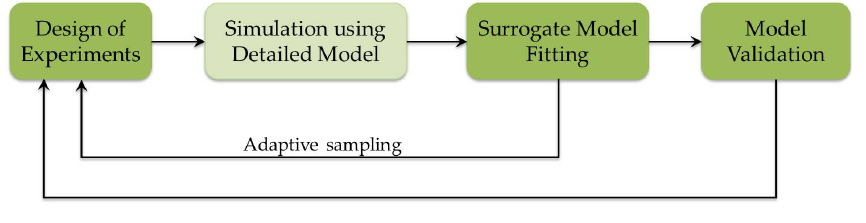
Figure 5. The major steps of building surrogate